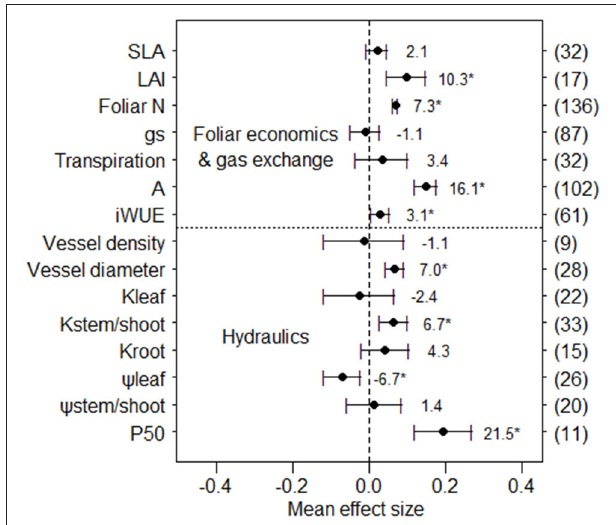
FIGURE 1 | Mean effect sizes of N addition on two group variables. Error bars indicate 95% confidence intervals (CIs). The number in parentheses represents the sample size for each variables. The percentage of change (%) for each variable is shown next to the point. The “ * ” denotes a significant response. Data are shown for specific leaf area (SLA), leaf area index (LAI), foliar N content (foliar N), stomatal conductance ( g s ), Transpiration rate (Transpiration), net photosynthetic rate (A), intrinsic water-use efficiency ( iWUE ), hydraulic conductance of leaves ( K leaf , stems/shoots ( K stem / shoot ) and roots ( K root ), leaf water potential ( ψ leaf ), stem/shoot water potential ( ψ stem / shoot ), and water potential corresponding to 50% loss of hydraulic conductivity ( P 50 ).